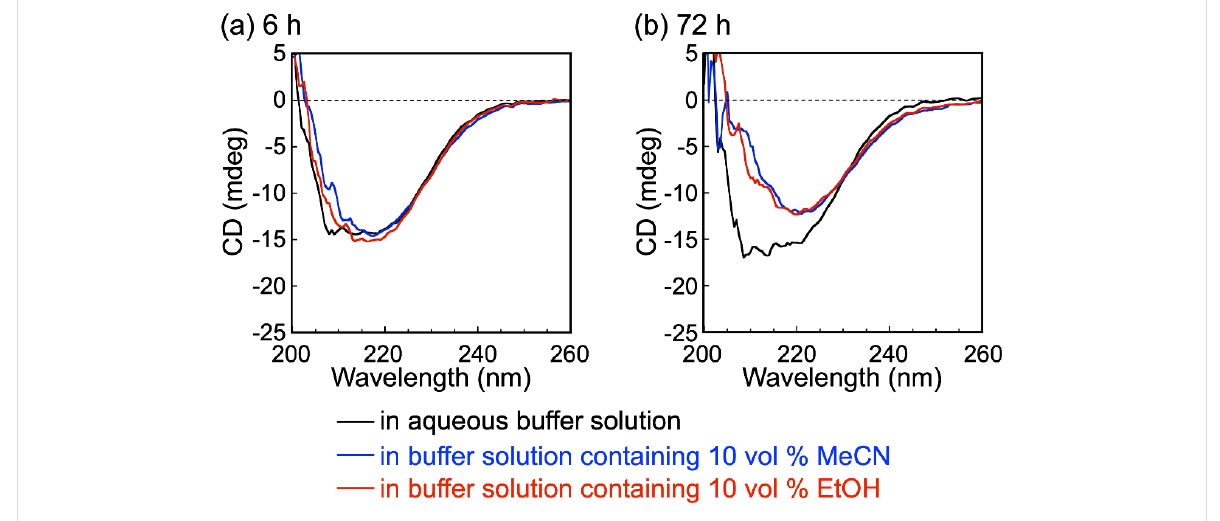
Figure 1: Corrected Figure 4 of the original publication.